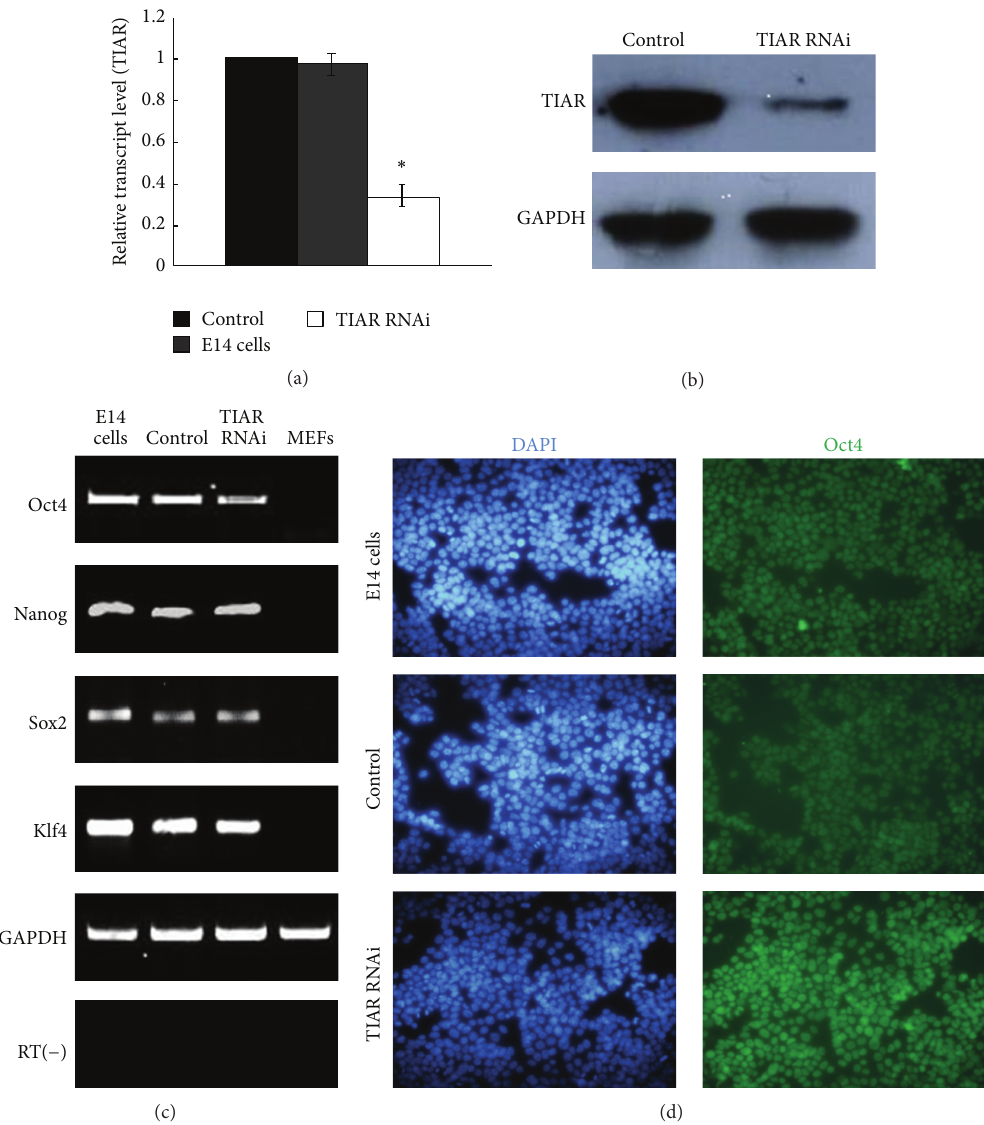
Figure 1: TIAR silencing E14 cells maintained their self-renewal pluripotency. (a) Quantitative RT-PCR analysis of the gene expression of TIAR in TIAR RNAi E14 cells and pSIREN-RetroQ control E14 cells. (b) Western blot analysis of the expression of TIAR in TIAR RNAi E14 cells and pSIREN-RetroQ control E14 cells. (c) RT-PCR analysis of the expression of Oct4, Nanog, Sox2, and Klf4 in TIAR RNAi E14 cells and pSIREN-RetroQ control E14 cells. E14 cells and mouse embryonic fibroblasts (MEFs) were used as a control. (d) Immunofluorescence analysis of the expression of Oct4 in TIAR RNAi E14 cells and pSIREN-RetroQ control E14 cells (200x). ∗ 𝑃 < 0.05 by one-way ANOVA. Control: pSIREN-RetroQ control E14 cells; TIAR RNAi: TIAR RNAi E14